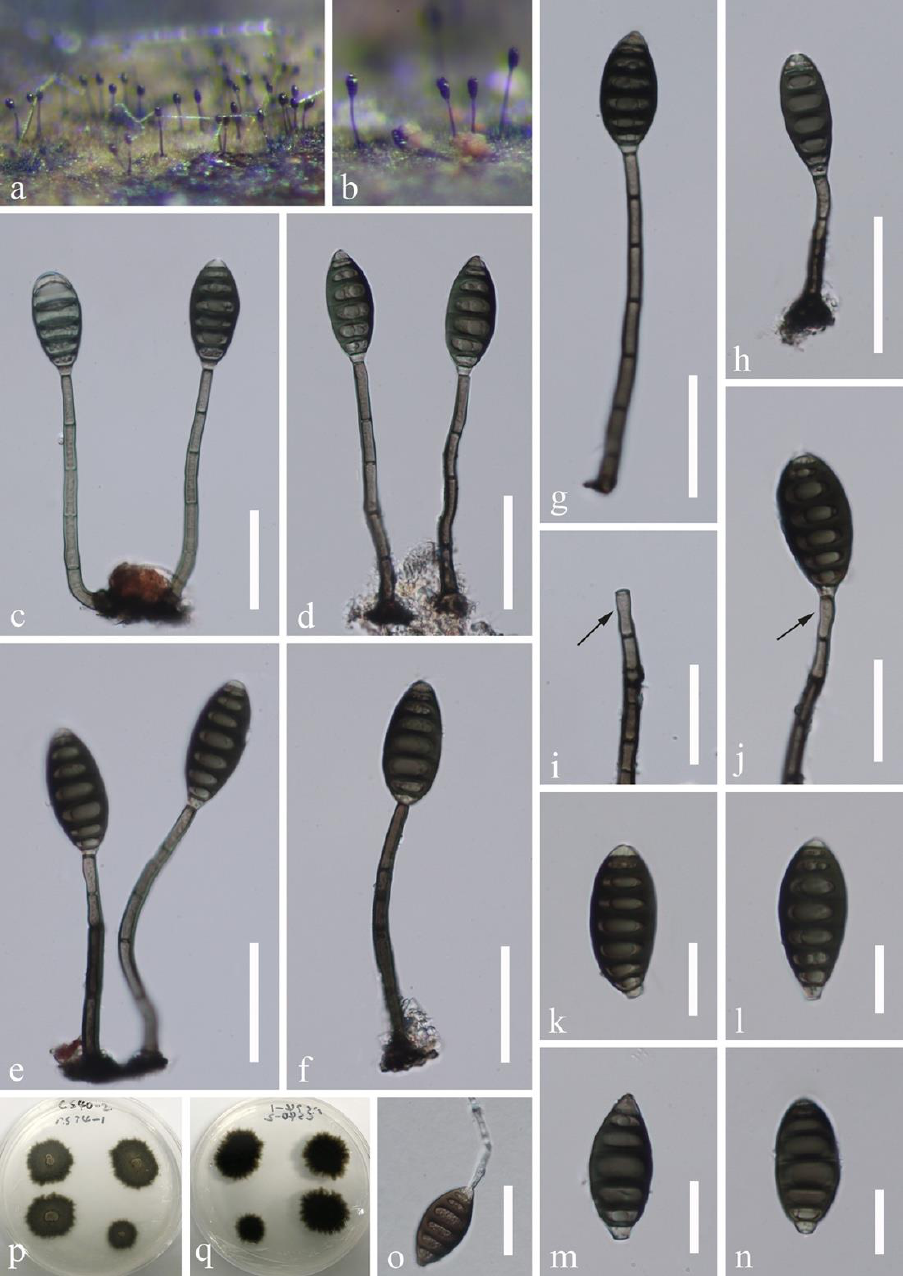
Figure 5. Distoseptispora fusiformis (HKAS 112617, holotype). ( a , b ) Colonies on woody substrates. ( c – h ) Conidiophores with conidia. ( i , j ) Conidiogenous cells. ( k – n ) Conidia. ( o ) Germinated conidium. ( p , q ) Culture, p from above, q from below. Scale bars: ( c – h ) 40 μm, ( i , j , o ) 30 μm, ( k – n ) 20 μm. Distoseptispora hyalina J. Yang and K.D. Hyde, sp. nov., Figure 6.